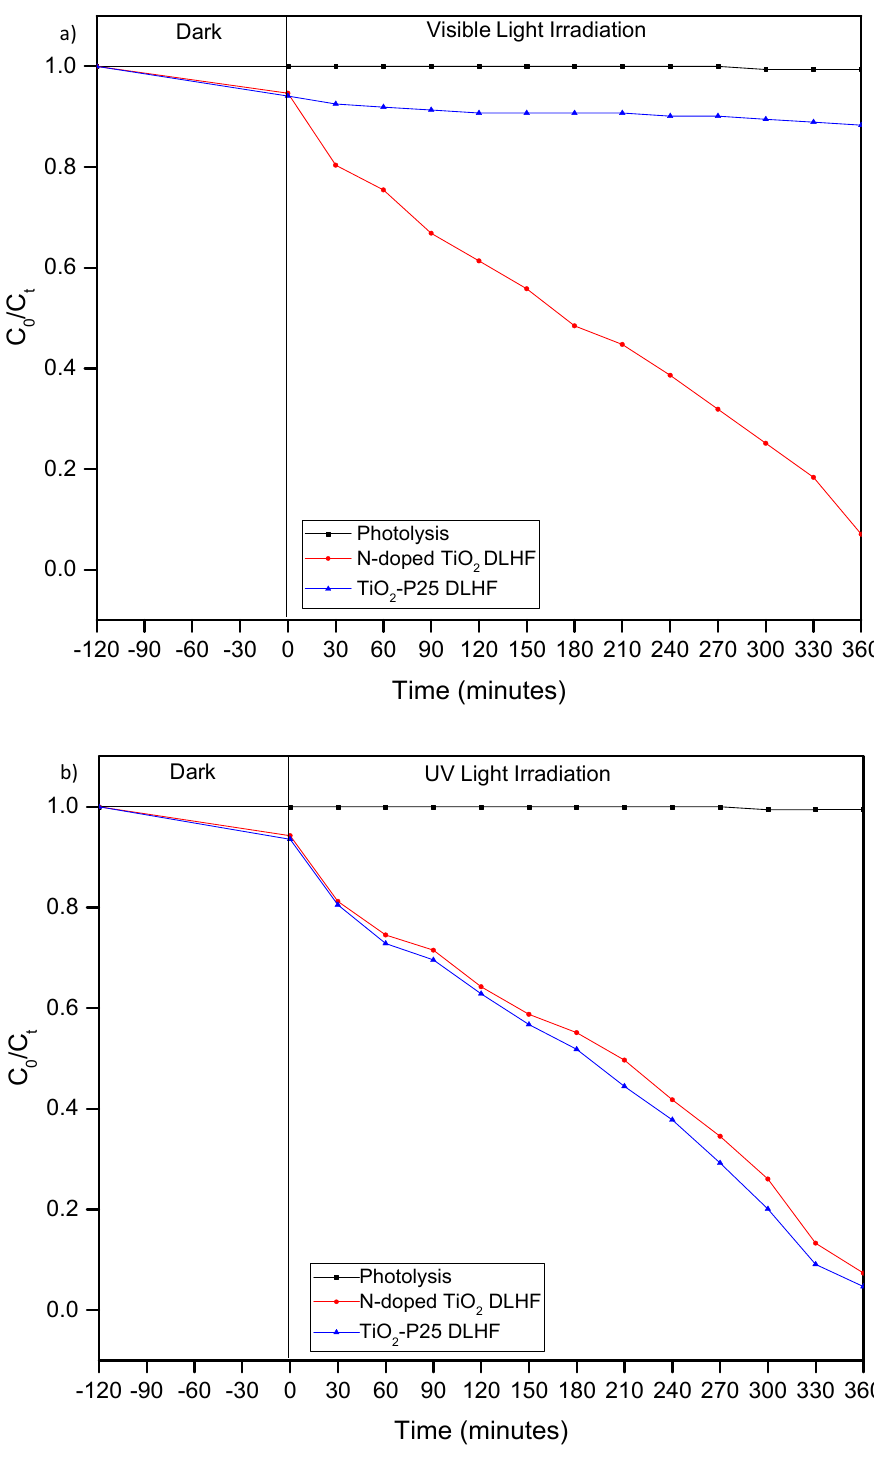
Figure 5. Photocatalytic degradation of BPA by N-doped TiO 2 and TiO 2 -P25 DLHF membrane under ( a ) visible light and ( b ) UV light irradiation for 360 min of activity. 3.3. BPA-Treated Water Ameliorated Its Detrimental Effects in Comparison to BPA-Untreated Water Rats were randomly divided into 3 groups: Group 1 (Vehicle Control Group (VHC); Tween 80 control group), Group 2 (Untreated (UT) BPA water), and Group 3 (Treated (T) BPA water) ( n = 4–6). Rats were administered with BPA untreated and treated water by N-doped TiO 2 DLHF membrane (from Section 2.5) for 21 days. The initial concentration of untreated BPA water was 5ppm [33–35].